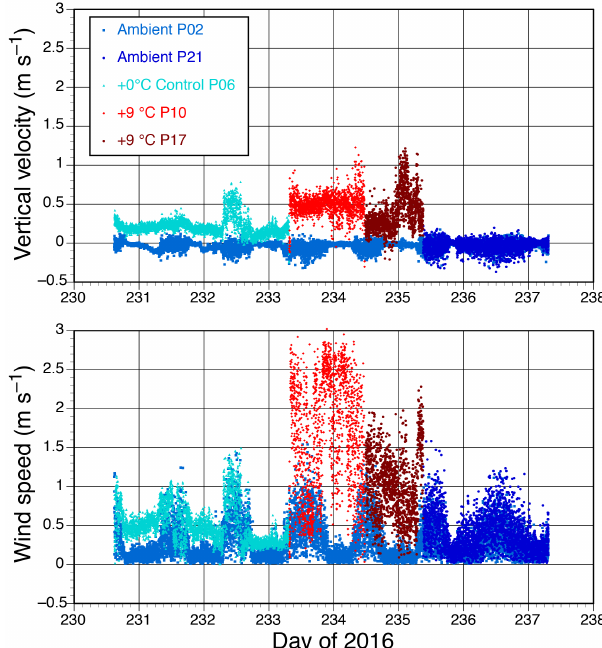
Figure 13. 1min vertical wind velocity ( U z ; upper graph) and mean horizontal wind speed ( U x and U y ; lower graph) for unchambered ambient and enclosed plots of the SPRUCE study during the sum- mer of